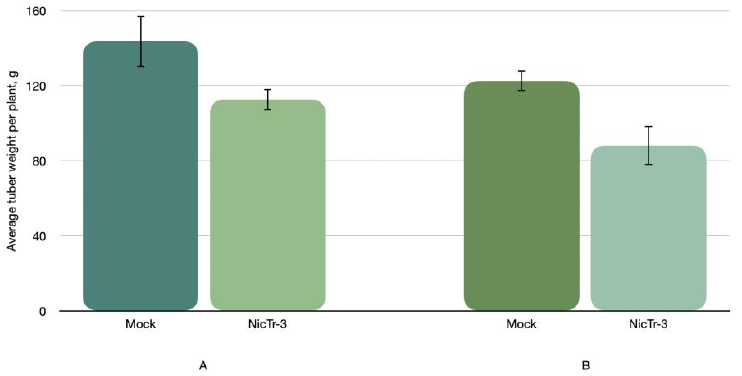
Figure 2. Average tuber weight (g) per plant inoculated with the PSTVd strain NicTr-3 and mock- inoculated plants of cv. Colomba: ( A ) — after the first inoculation, ( B ) — tubers of the second genera- tion obtained from PSTVd-infected